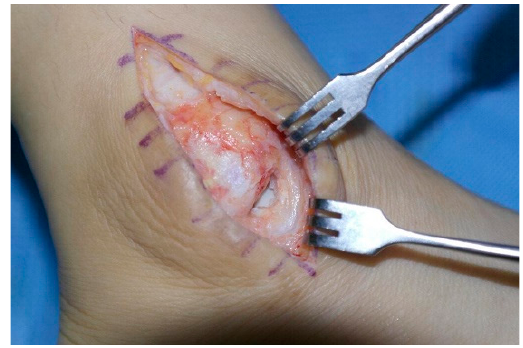
Figure 4. Defect of the ankle joint capsule.